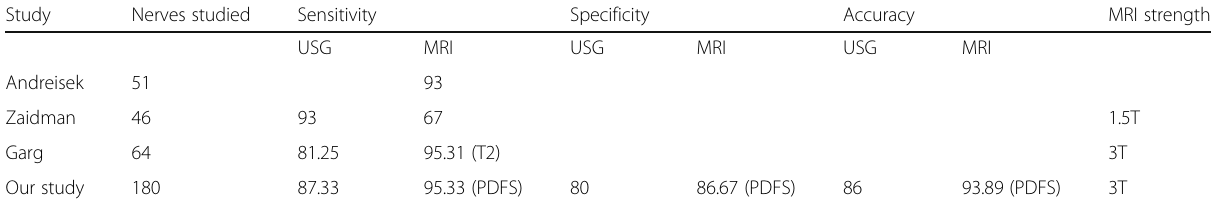
Table 6 Comparative analysis with existing literature Study Nerves studied Sensitivity Specificity Accuracy MRI strength